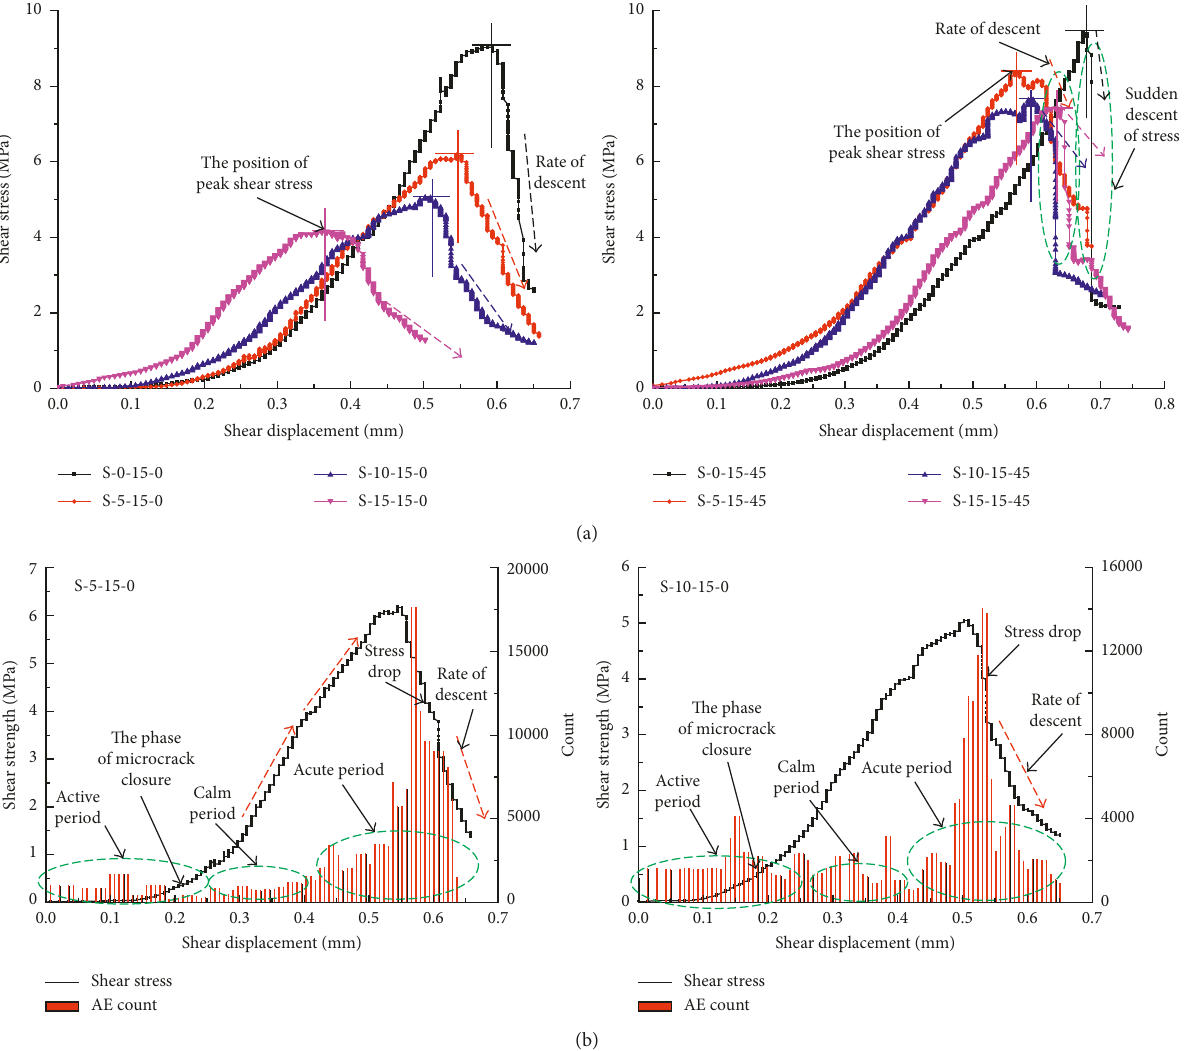
Figure 10: The effect of joint overlap on the shear stress-displacement curve and AE count: (a) the shear stress-displacement curve of samples containing different joint overlap lengths; (b) the variation of acoustic emission counts for different overlapping